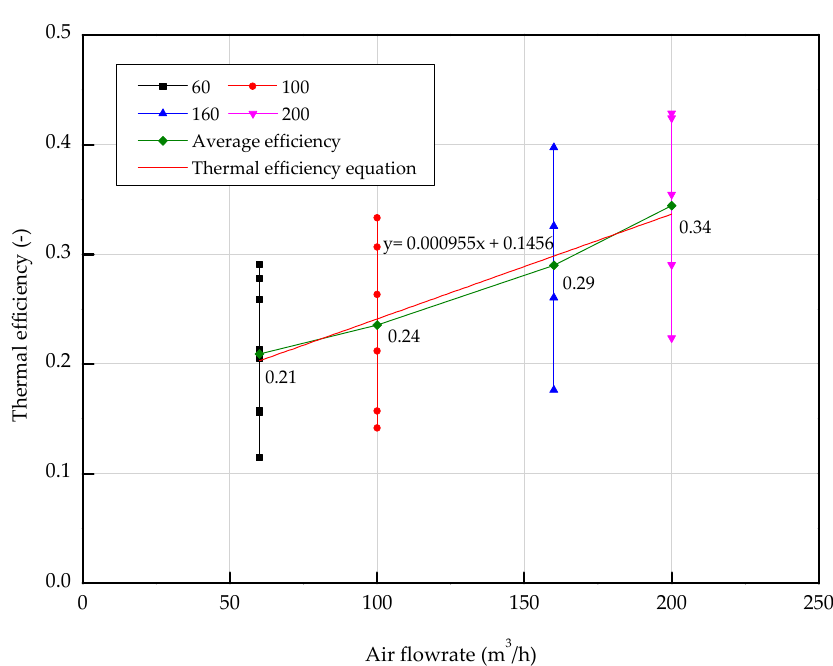
Figure 5. E ff ect of the air flow rate on the thermal e ffi Figure 5. Effect of the air flow rate on the thermal efficiency. Figure 5. Effect of the air flow rate on the thermal efficiency.